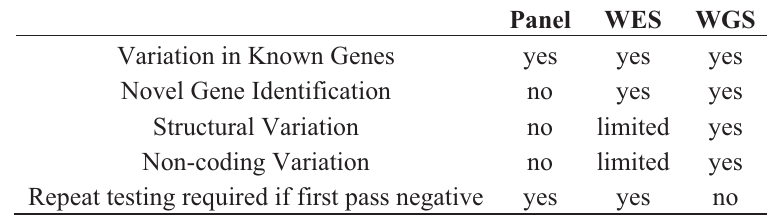
Table 1. Comparison of Panel, whole exome sequencing (WES) and whole genome sequencing